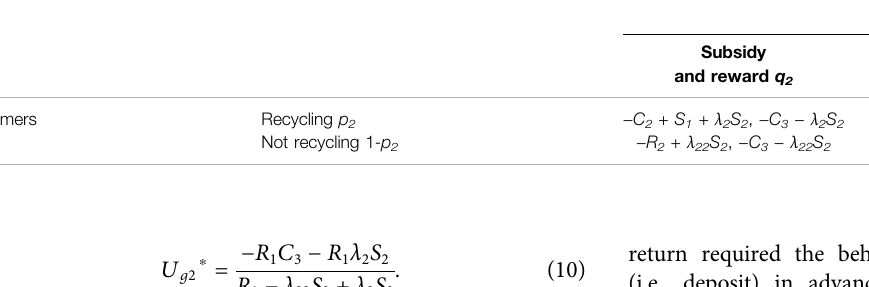
TABLE 2 | Game revenue matrix between farmers and government under the intervention mechanism of subsidy and